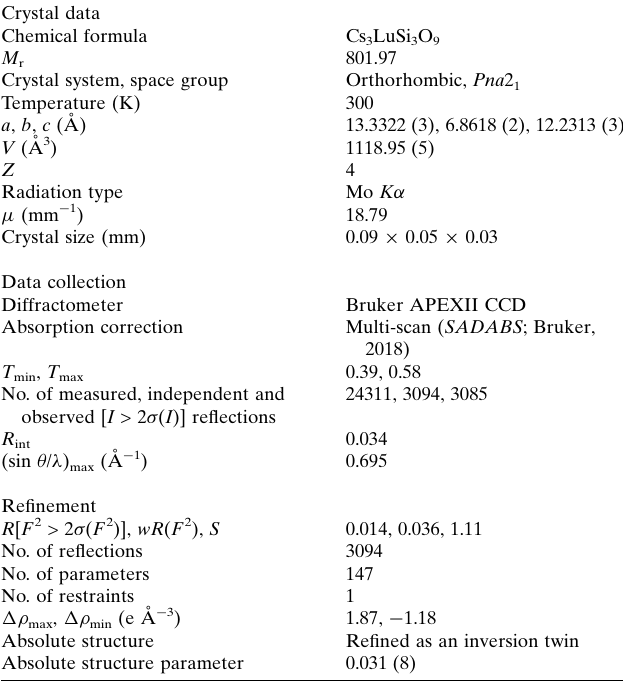
Crystal data Chemical